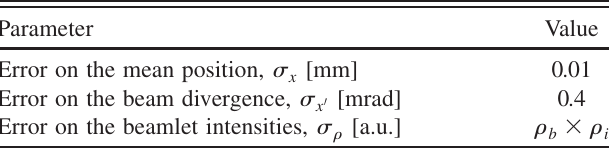
TABLE II. The errors on the position and the divergence of the beamlets have been calculated in terms of the slit width and the mask-screen distance. The error on the beamlet intensities has been calculated as the product of the measured relative inten- sities of the individual beamlets, (cid:4) i , and the average electron beam intensity stability, (cid:4) b , during the measurement. Parameter Value Error on the mean position, (cid:2) x [mm] 0.01 Error on the beam divergence, (cid:2) x 0 [mrad] 0.4 Error on the beamlet intensities, (cid:2) (cid:4) [a.u.] (cid:4) b (cid:6) (cid:4) i